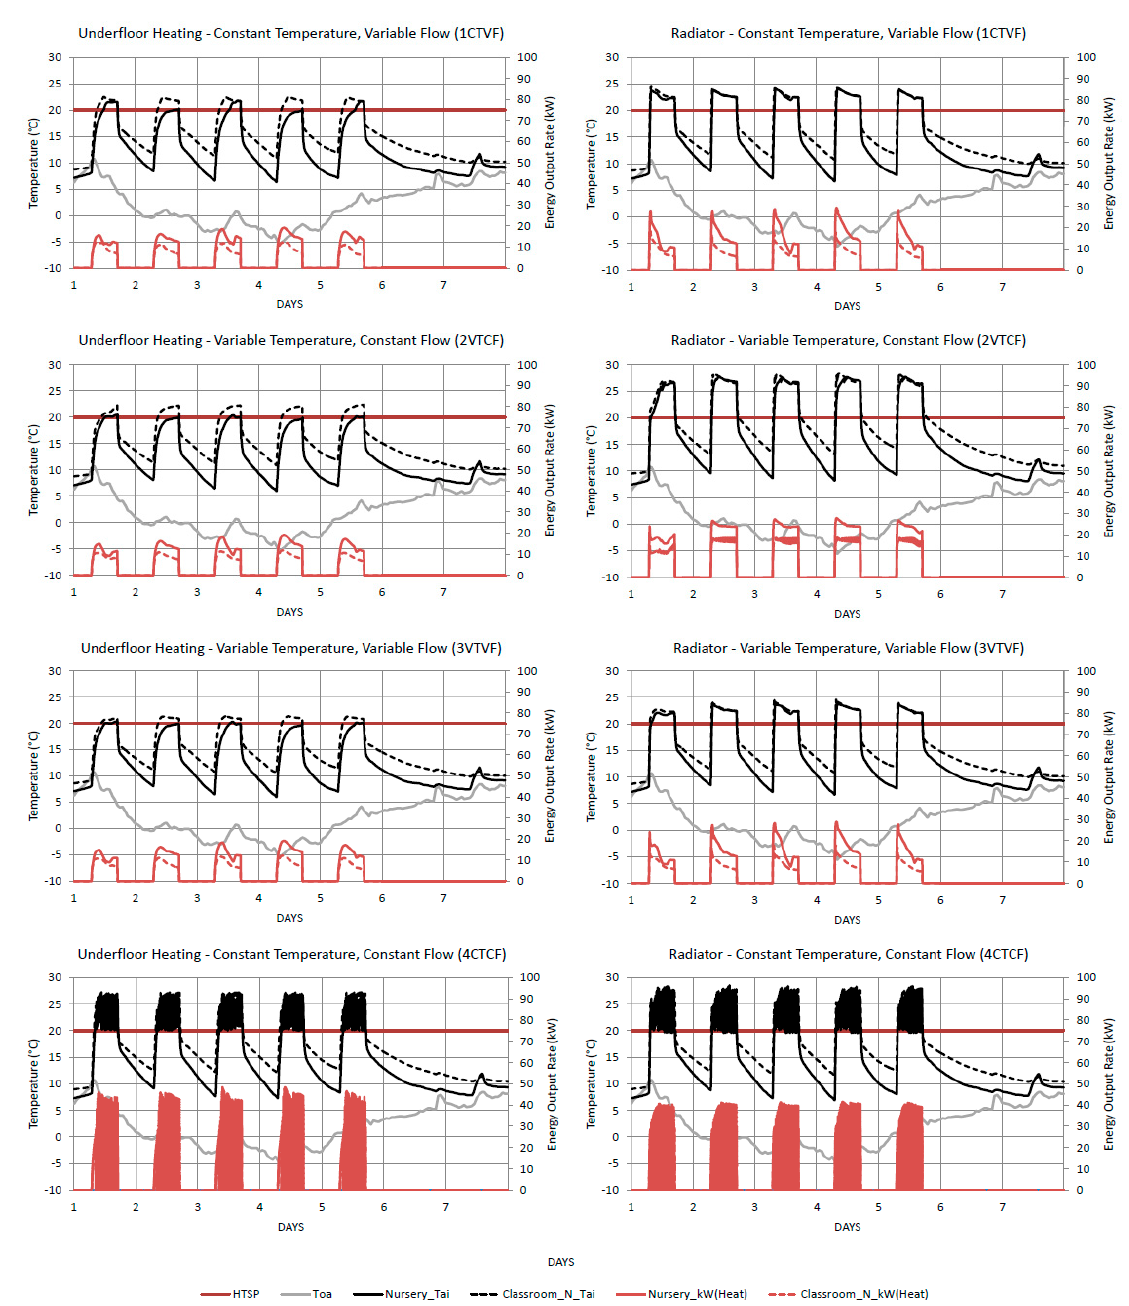
Figure 4. Temperature and energy profiles for a peak winter week.